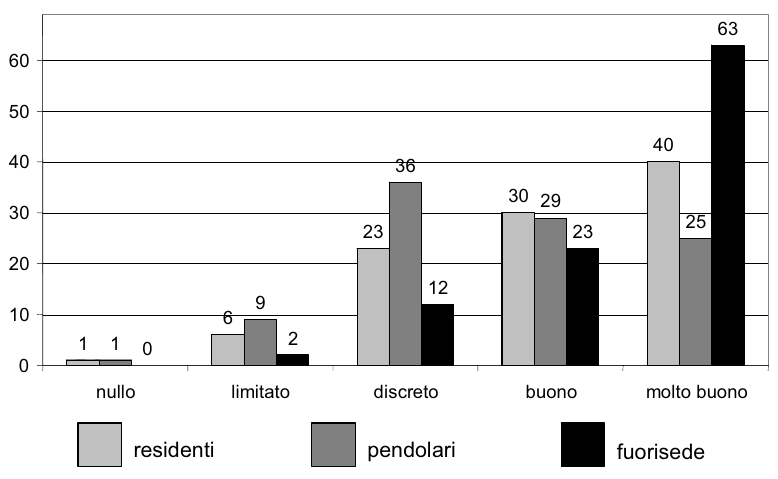
Figura 2 – Distribuzione percentuale degli studenti in base al grado di integrazione con gli altri stu-